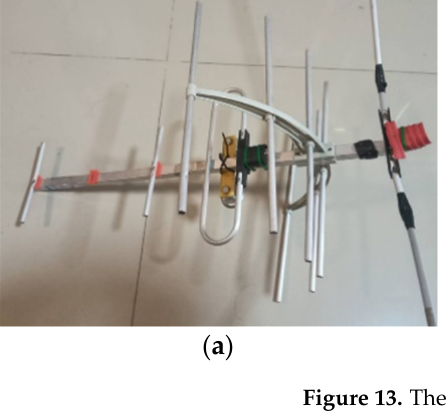
liquid were investigated. Zhang and Glover [51] presented a compact ultra ‐ wideband